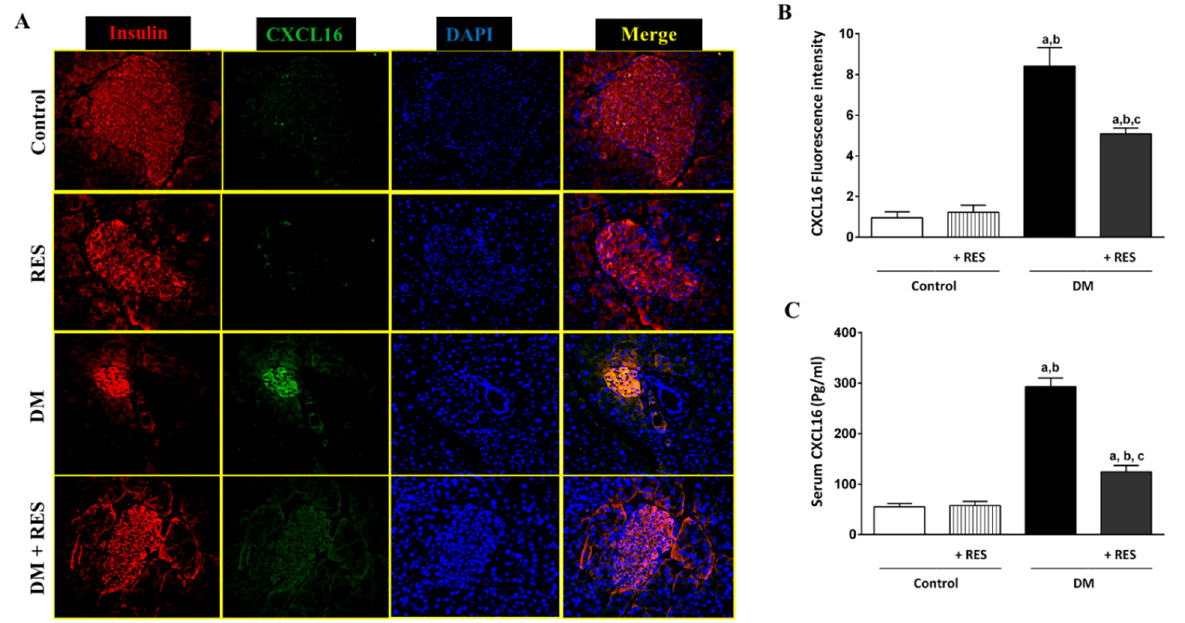
Figure 3. ( A ) Double immunofluorescence staining for insulin (red), a pancreatic β cell marker, and CXCL16 (green) was performed; basal expression of pancreatic β cell CXCL16 in normal control and RES-treated mouse tissues. Increased CXCL16 expression in pancreatic β cells was confirmed by the co-localization of CXCL16 with insulin. Marked reduction of CXCL16 expression in mouse pancreatic β cells of RES-treated mice with STZ was seen; ( B ) Fluorescence intensity of CXCL16 protein expression for all groups was quantified and blotted; ( C ) Serum levels of CXCL16 using ELISA in all treated groups show similar findings of immunofluorescence. Data represent mean ± SEM: a difference is significant compared to control group; b difference is significant compared to RES group; c difference is significant compared to diabetic group at p <